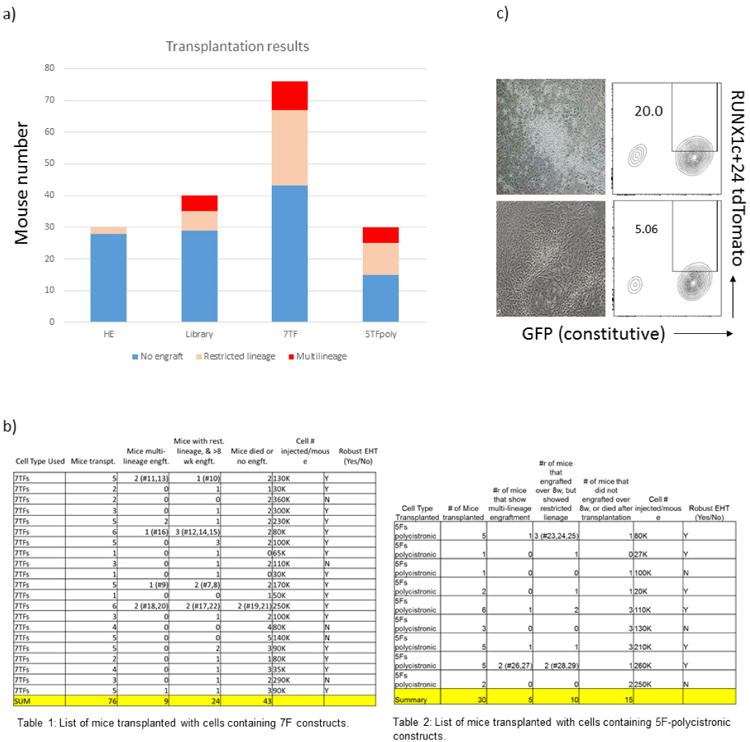
Compiled data from transplantation experiments performed so fara, b, Total engrafted mice assessed in primary transplantation at various time points. a, Histogram of total mice injected with haemogenic endothelium cells and haemogenic endothelium cells infected with indicated library or constituent transcription factors. Haemogenic endothelium only: 2 out of 30 mice engrafted, none of which were multi-lineage (myeloid cells, erythroid cells, B cells and T cells); library: 11 out of 40 mice engrafted, 5 multi-lineage; 7 transcription factors: 33 out of 76 mice engrafted, 9 multi-lineage; 5TFpoly: 15 out of 30 mice engrafted, 5 multi-lineage. Engraftment was assessed from bone marrow at 4–16 weeks. b, Tables 1 and 2 show compiled data. c, Representative photomicrographs and FACS plots of robust EHT (top) and failed EHT (bottom). The appearance of round cells budding from adherent haemogenic endothelium cells by direct microscopic visualization was assessed routinely. RUNX1c+24 reporter positivity of haemogenic endothelium cells at day 3 of culture likewise reflected robustness of EHT (20% versus 5%).